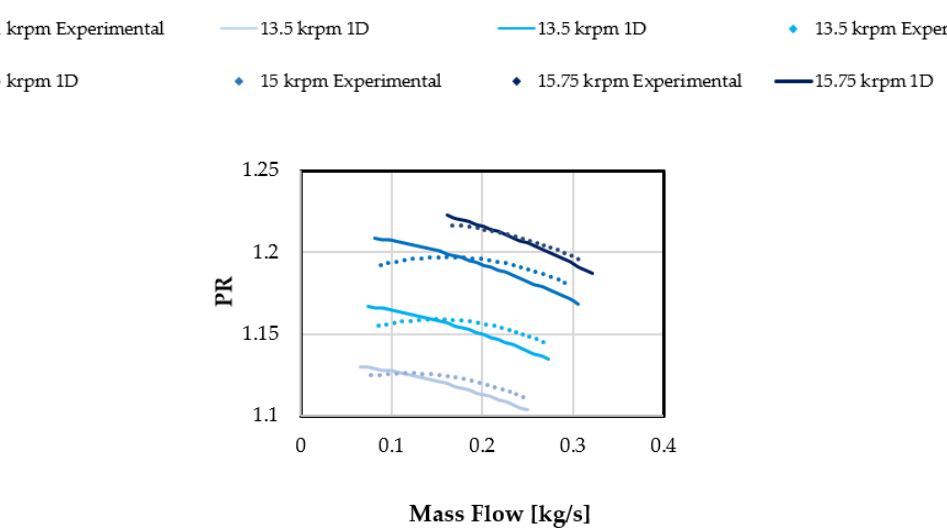
efficiency vs mass flow rate; ( b ) pressure ratio vs mass flow rate.